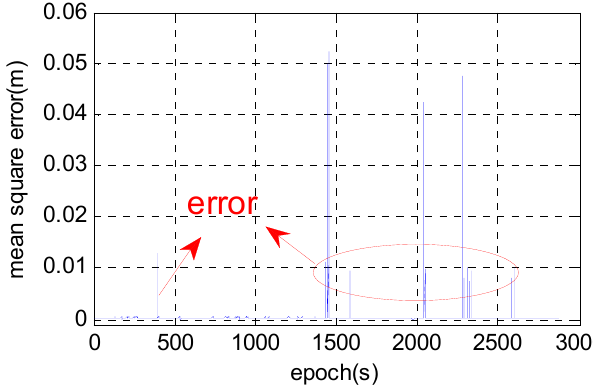
Figure 4. Variation of the absolute value of mean square error.